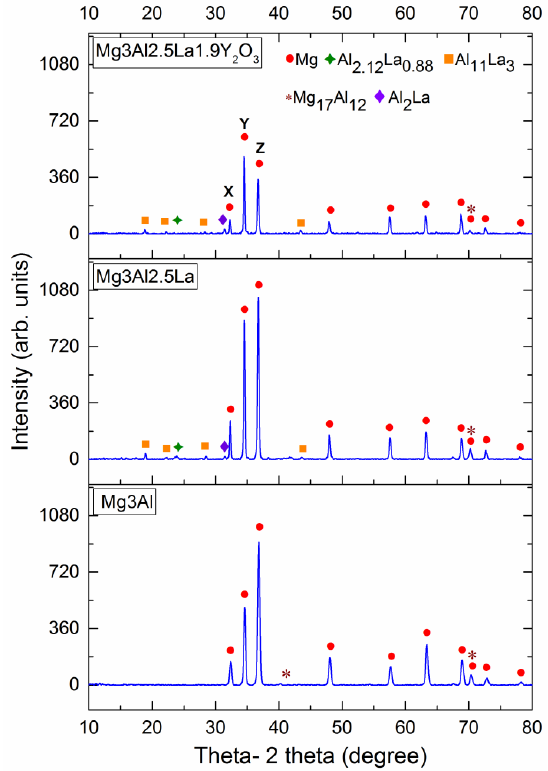
Figure 4. X-ray diffraction results of Mg–3Al, Mg–3Al–2.5La and Mg–3Al–2.5La–1.9Y 2 O 3 alloys.